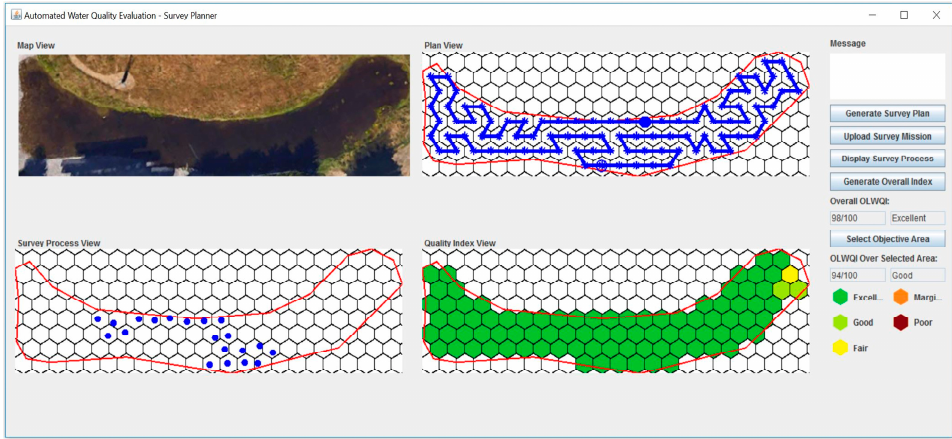
Figure 8. Graphic User Interface (GUI).